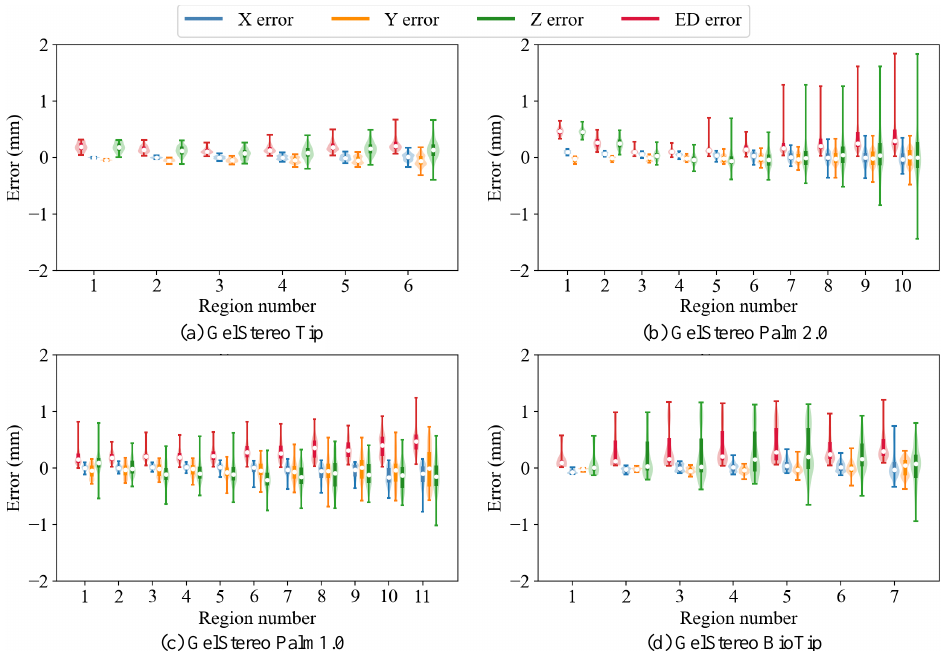
Figure 10. Violin plot showing the distribution of 3D reconstruction errors at different contact regions. The X error, Y error, Z error, and ED error denote the error on the X-axis, Y-axis, Z-axis, and Euclidean distance between the reconstructed 3D points and the ground truth. The white dots indicate medians. Table 8. The results of ablation studies on the UMMR calibration method. The unit of X MAE, Y MAE, Z MAE, and MEDE is mm. GelStereo